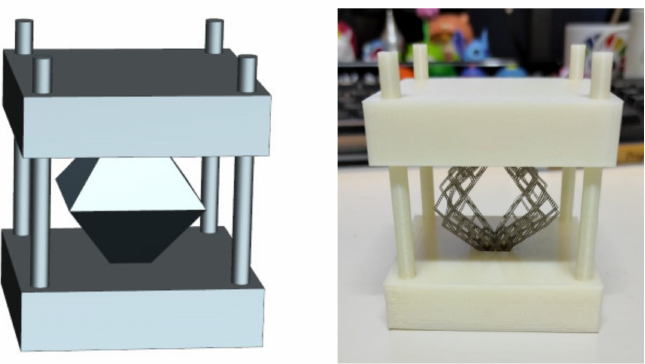
Figure 11. ( Left ) Designed structure for experimental validation. ( Right ) Real structure for experi- mental validation.